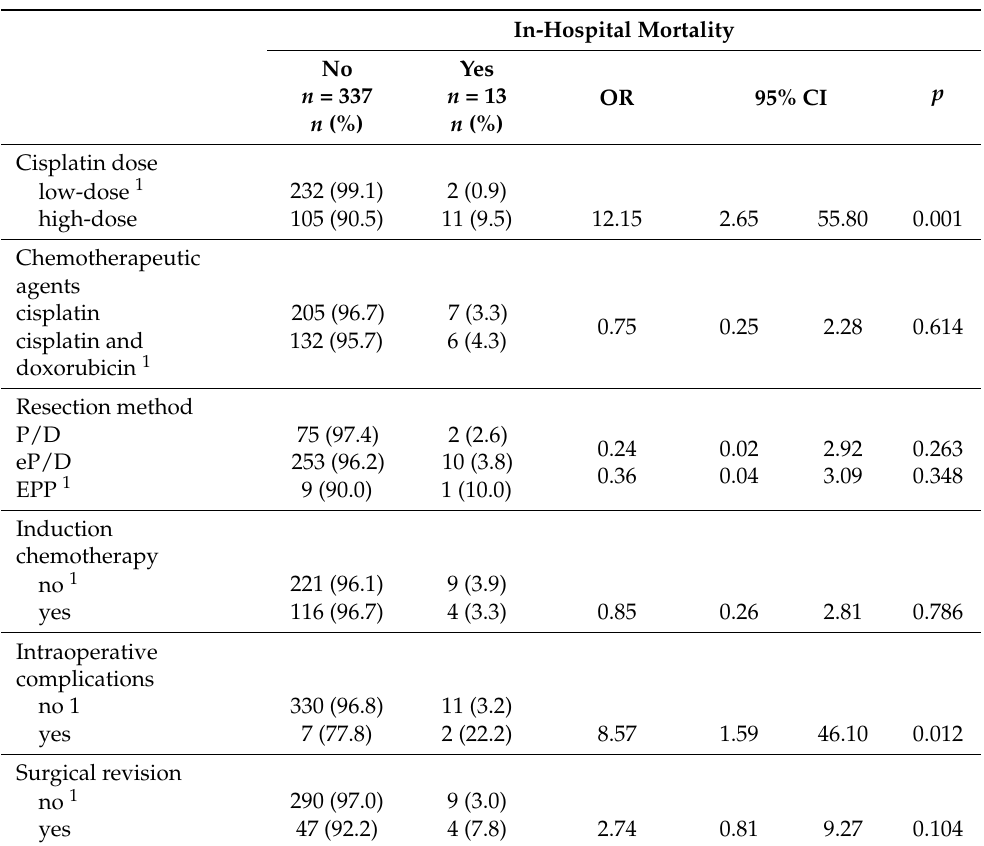
Table 4. Risk factors for in-hospital